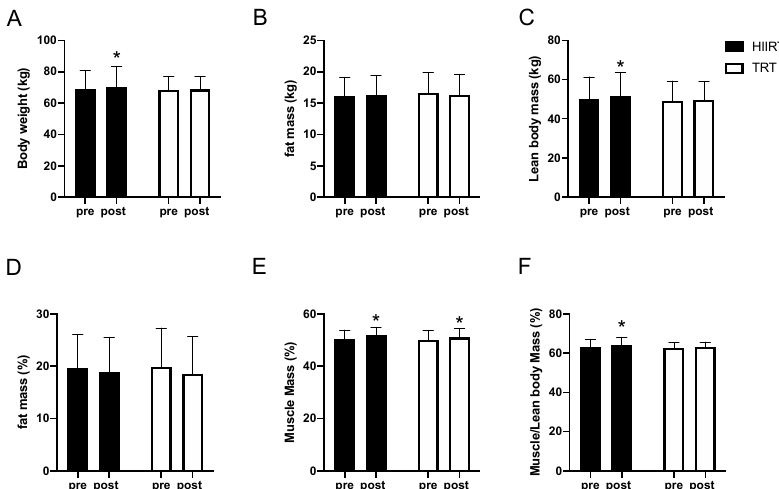
Figure 2. Body composition analysis. * significantly different from baseline ( p < 0.05). HIIRT, High Intensity Interval Training; TRT, Traditional Resistance Training.